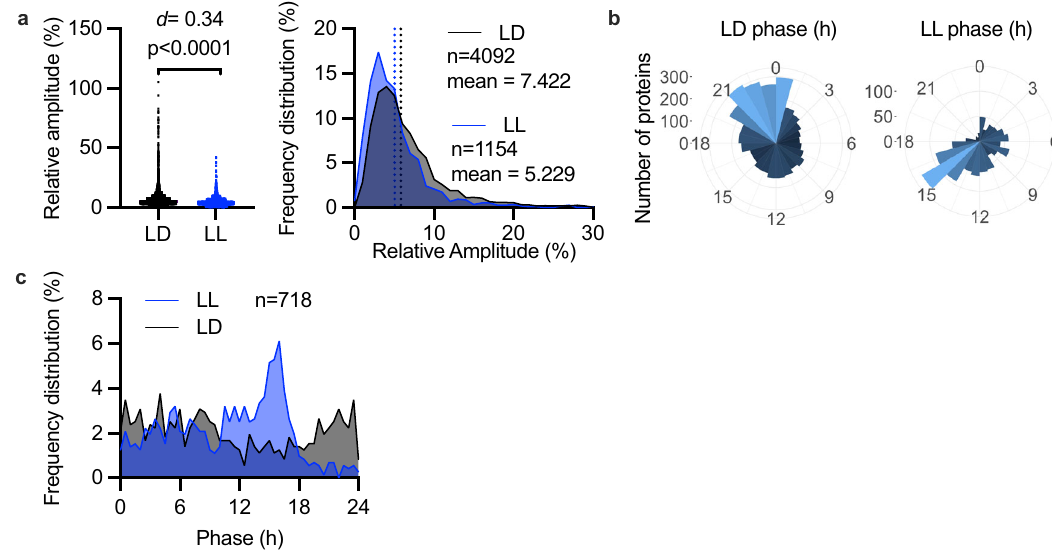
Fig. 3 No clear relationship exists between entrained and free-running temporal proteomes. a The relative amplitude of rhythmic proteins under LD or LL, expressed individually or as frequency distributions. b Circular histograms showing the number of rhythmic proteins in LD and LL that peak at each 1-hour phase interval. c Phase distribution under LD or LL of proteins that were signi fi cantly rhythmic in both. Statistics re fl ect Mann – Whitney tests and Cohen ’ s d . Source data can be found in Supplementary Data